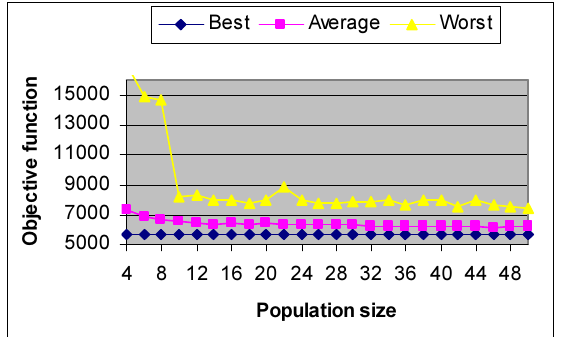
Fig. 13. Dependency of solution results on the popula- tion size Thus. the smaller populations (until 26 individuals) show worse results; for longer populations the results are stable. In all cases, the global solution was obtained.